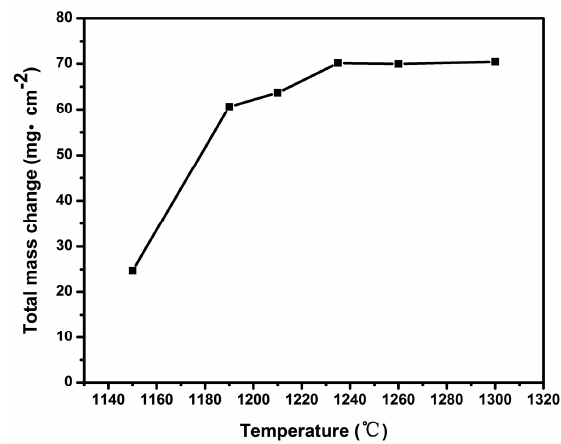
Figure 6. Total mass gain at different oxidation temperatures.